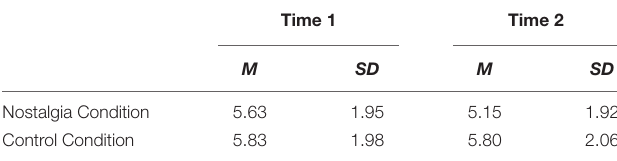
TABLE 1 | Pain severity scores as a function of nostalgia